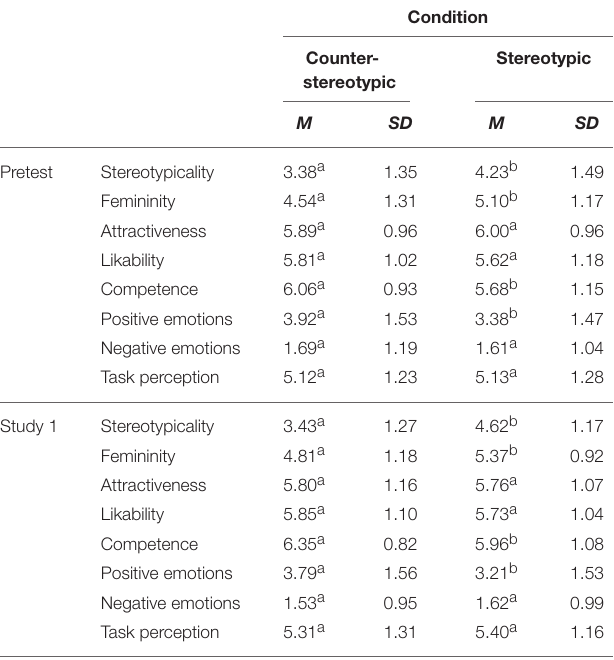
TABLE 2 | Differences in ratings between the counter-stereotypic and stereotypic condition in the Pretest Study and in Study 1.